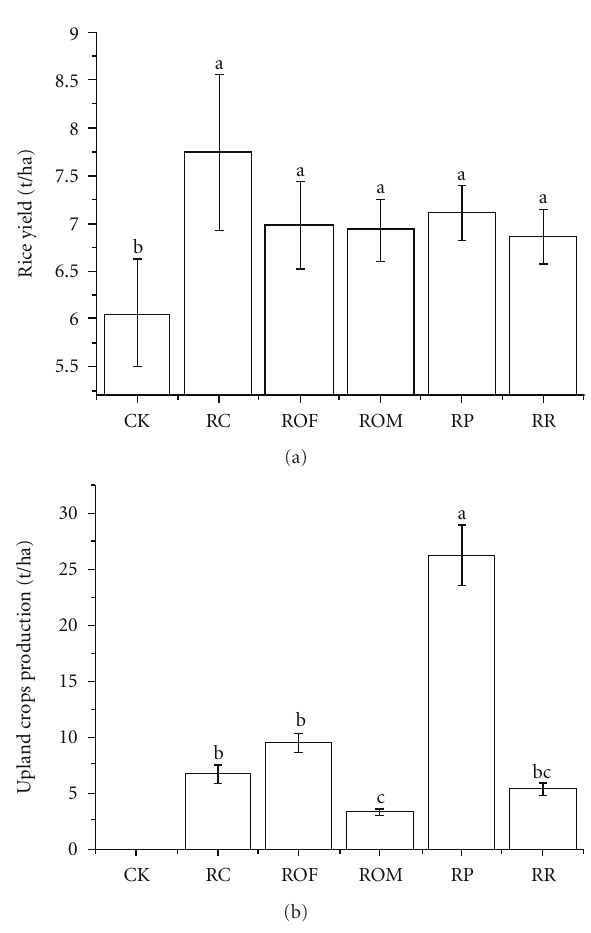
Figure 1: E ff ect of di ff erent paddy-upland crops rotations on the rice yield (a) and upland crops biomass production (b) during 2010-2011. Error bars represent standard deviation, n = 3. Values followed by di ff erent lowercase letters within depth are significantly di ff erent between treatment by Tukey’s test ( P < 0 .